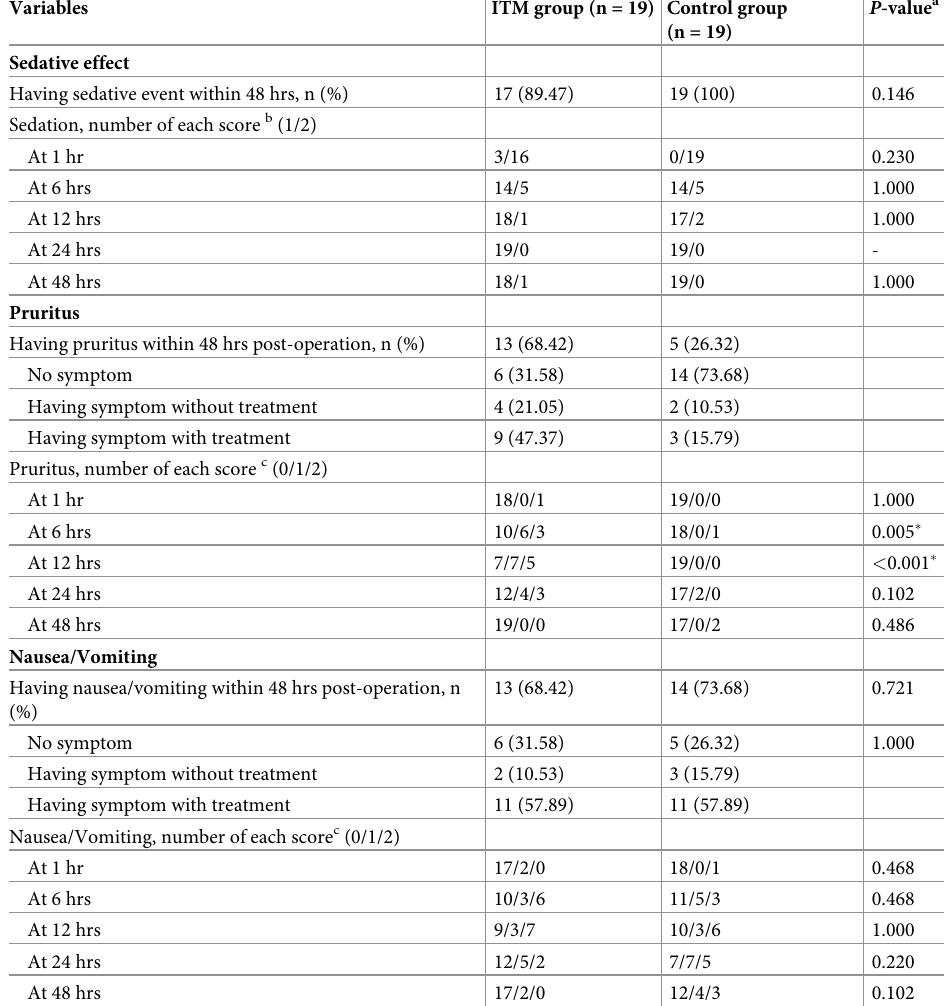
Table 3. Common opioid-related side effects (sedative effect, nausea/vomiting, and pruritus).